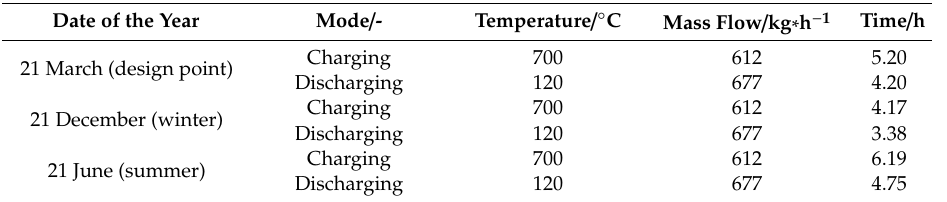
Table 2. Test parameter [27].